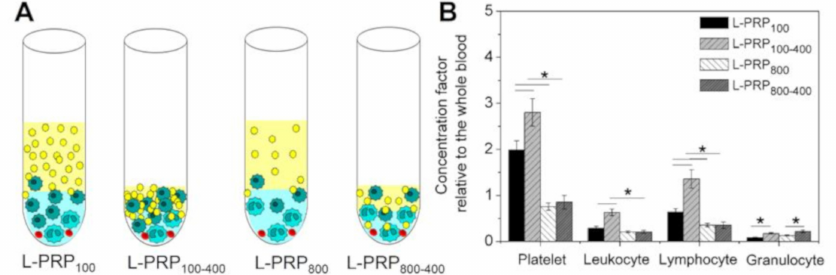
Figure 3. ( A ) Schematic illustration representing the concentration of the blood components in each L-PRP. ( B ) The calculated concentration factors relative to the whole blood. Note: * p <